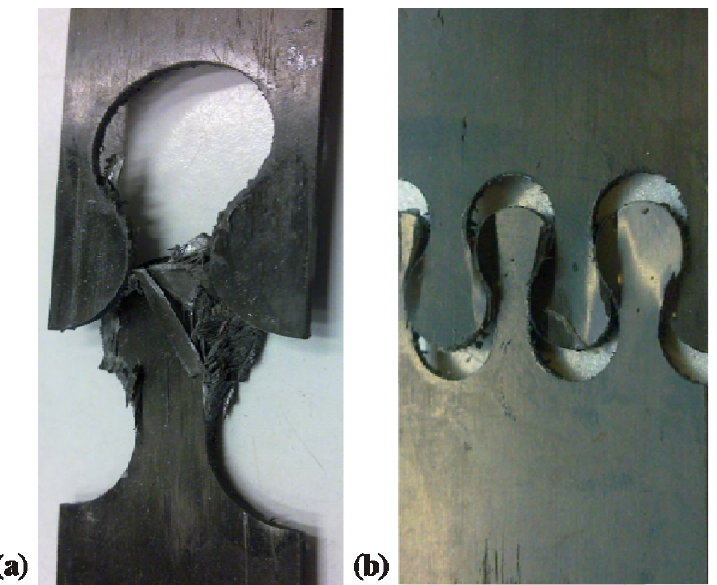
Figure 9. Typical failure of interlocks during tensile